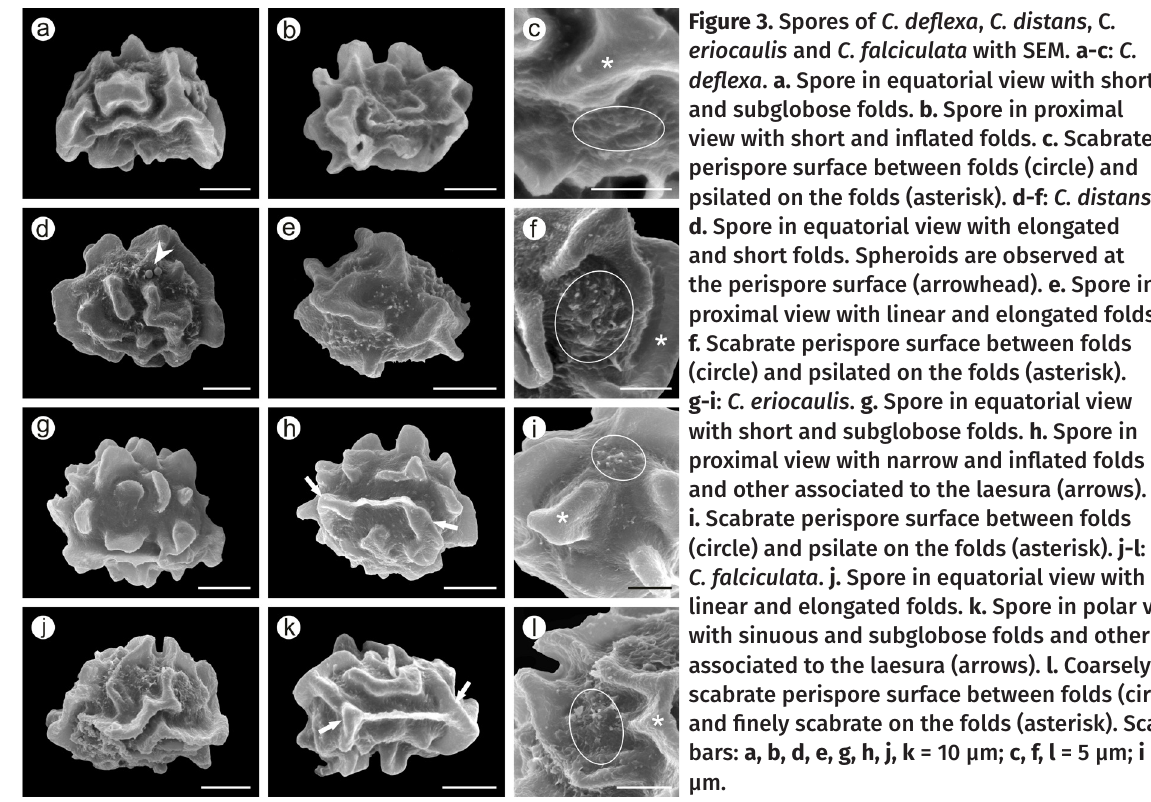
Figure 3. Spores of C. deflexa , C. distans , C . eriocaulis and C. falciculata with SEM. a-c : C. deflexa . a. Spore in equatorial view with short and subglobose folds. b. Spore in proximal view with short and inflated folds. c. Scabrate perispore surface between folds (circle) and psilated on the folds (asterisk). d-f : C. distans . d. Spore in equatorial view with elongated and short folds. Spheroids are observed at the perispore surface (arrowhead). e. Spore in proximal view with linear and elongated folds. f. Scabrate perispore surface between folds (circle) and psilated on the folds (asterisk). g-i : C. eriocaulis . g. Spore in equatorial view with short and subglobose folds. h. Spore in proximal view with narrow and inflated folds and other associated to the laesura (arrows). i. Scabrate perispore surface between folds (circle) and psilate on the folds (asterisk). j-l : C. falciculata . j. Spore in equatorial view with linear and elongated folds. k. Spore in polar view with sinuous and subglobose folds and other associated to the laesura (arrows). l. Coarsely scabrate perispore surface between folds (circle) and finely scabrate on the folds (asterisk). Scale bars: a, b, d, e, g, h, j, k = 10 µm; c, f, l = 5 µm; i = 3